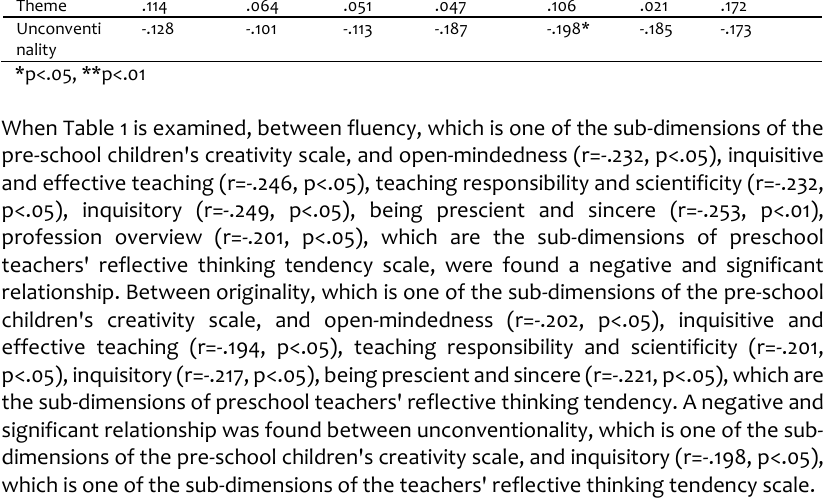
Teaching Inquisiti Open- Continuou responsibili ve and mindedn s and ty and effectiv ess purposefu scientificity e l thinking teaching